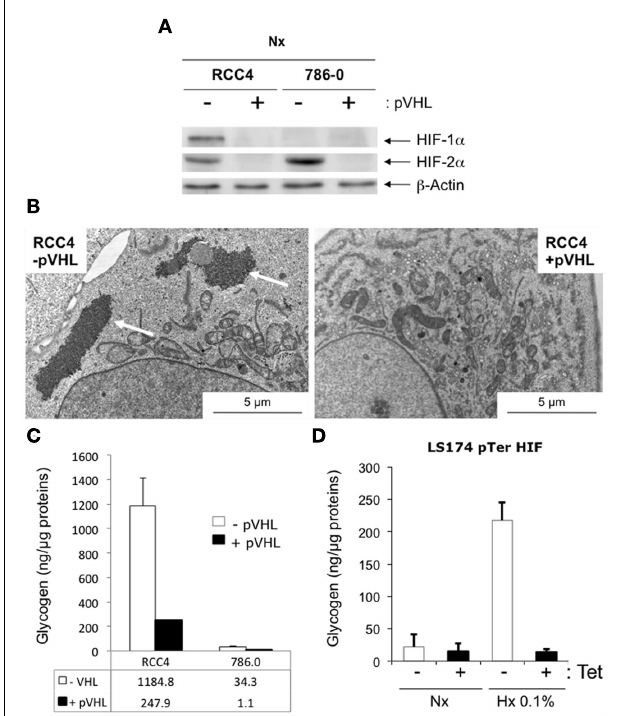
FIGURE 2 |Accumulation of glycogen in hypoxia is dependent on HIF-1. (A) RCC4 and 786-O cells in the absence ( − pVHL) or presence ( + pVHL) of pVHL were placed in normoxia for 24h.Total extracts were analyzed by immunoblotting with antibodies against HIF-1 α , HIF-2 α , and β -Actin. (B) Electron micrographs of RCC4 − pVHL (left panel) and RCC4 + pVHL (right panel) cells in normoxia. (C) Quantification of the amount of glycogen in RCC4 − pVHL (white bars) and + pVHL (black bars) cells grown in normoxia. (D) Quantification of the amount of glycogen in LS174 pTerHIF-1 α cells grown in normoxia (Nx; white bars) or hypoxia 0.1% O 2 (Hx 0.1% – black bars) in the absence ( − ) or presence ( + ) of tetracycline (Tet). Data represent the average of at least three independent